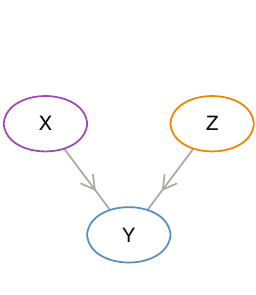
and estimate causal e ff ects from them.